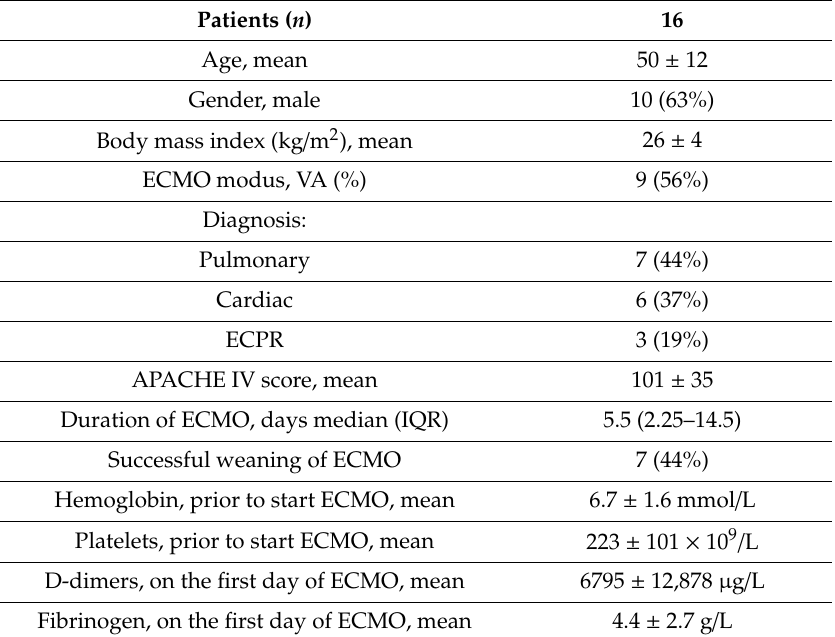
Table 1. Patient characteristics at